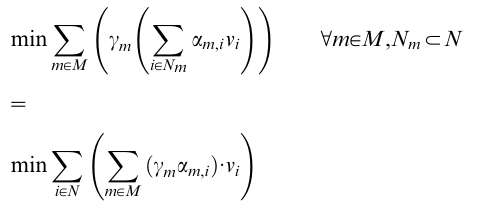
Figure S2 Profiles obtained for the objective function